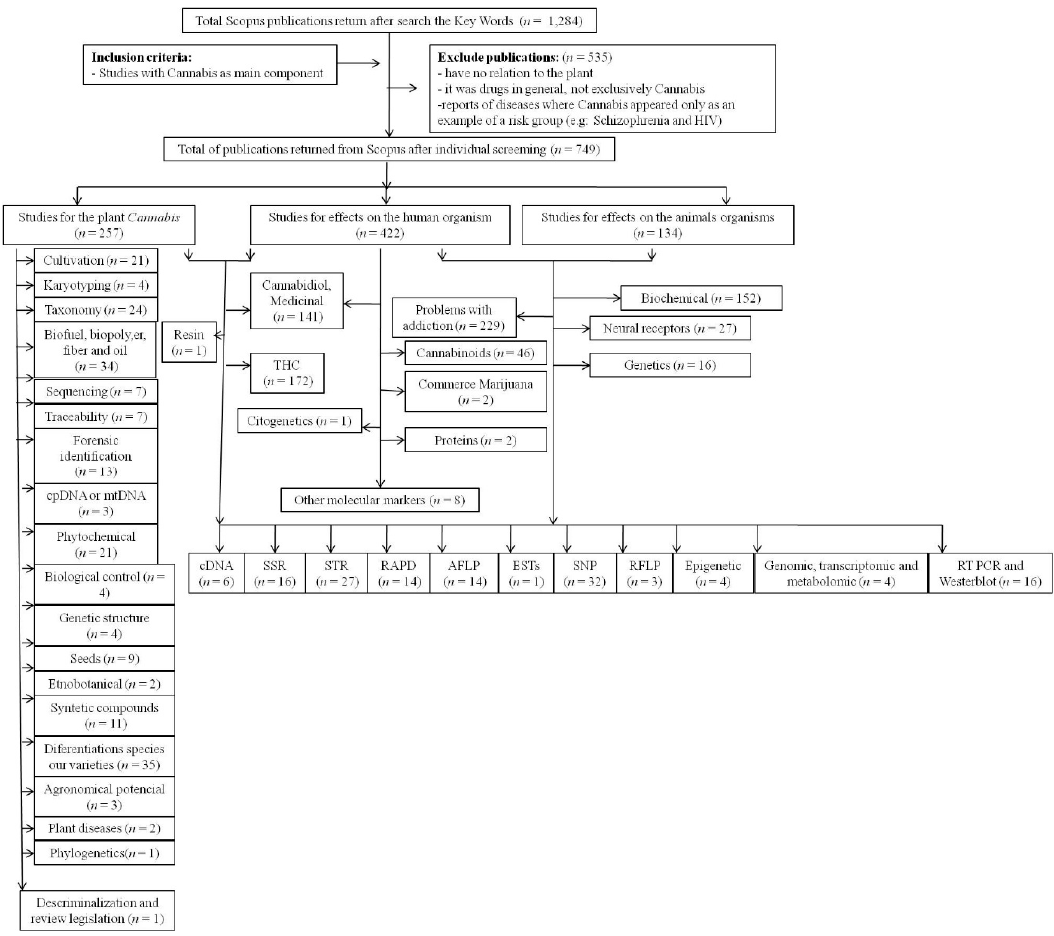
Figure 3. Flowchart of the scientific fields from the searched studies after the individual screening involving all search arguments employed in this study. involving all search arguments employed in this